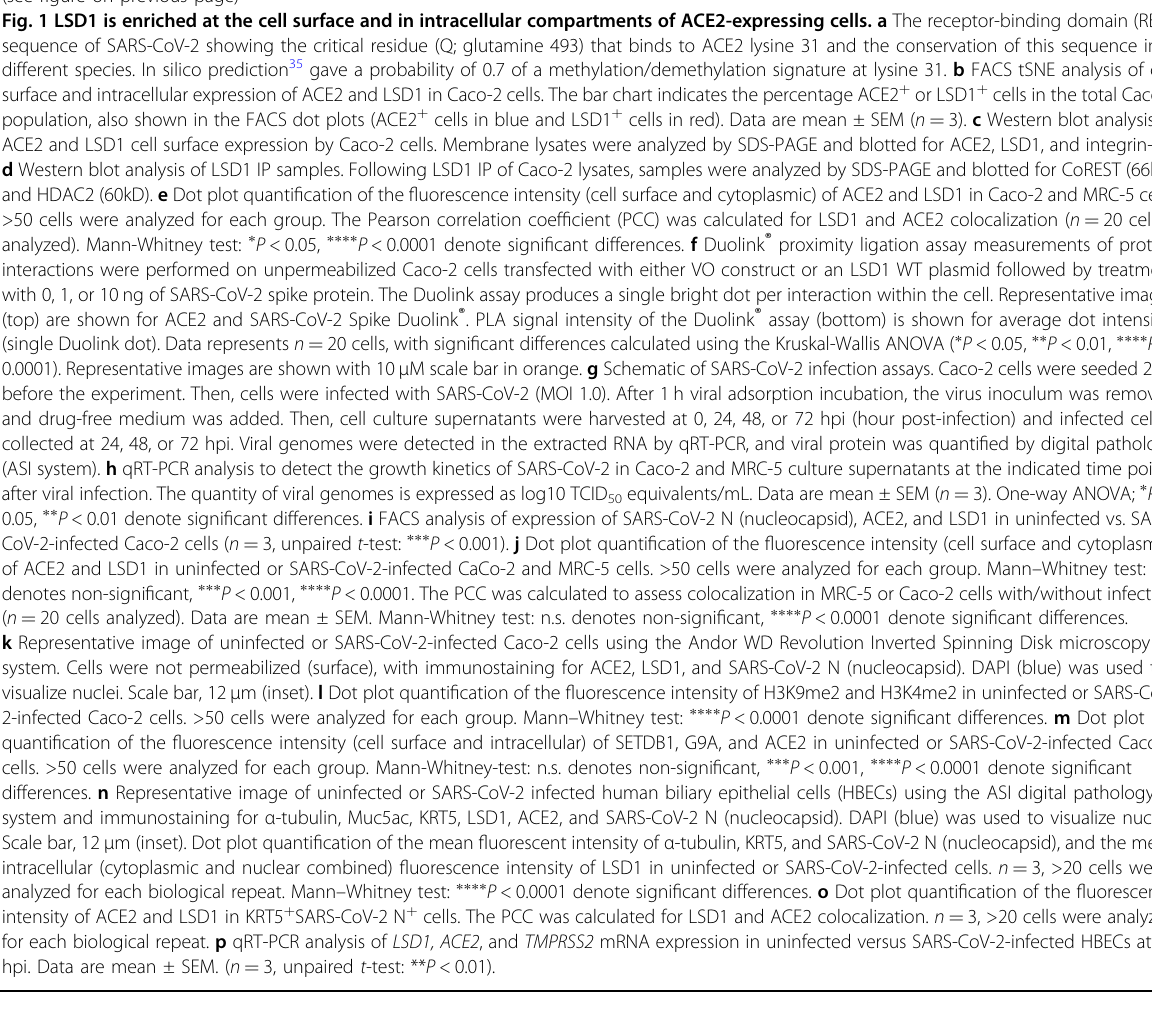
LSD1 and ACE2 expression coupled with t-distributed stochastic neighbor embedding (tSNE) analysis, all ACE2 + Caco-2 cells co-expressed LSD1 both at the cell surface and within intracellular compartments, suggesting